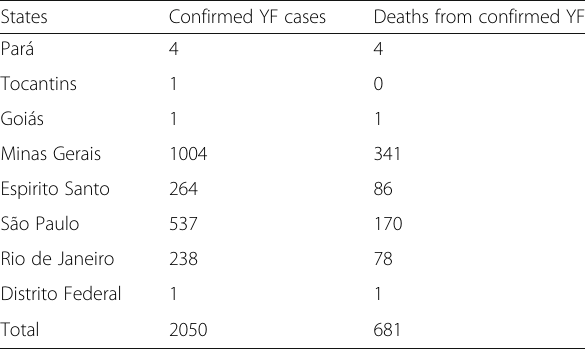
Table 1 Confirmed yellow fever cases and deaths in Brazil from